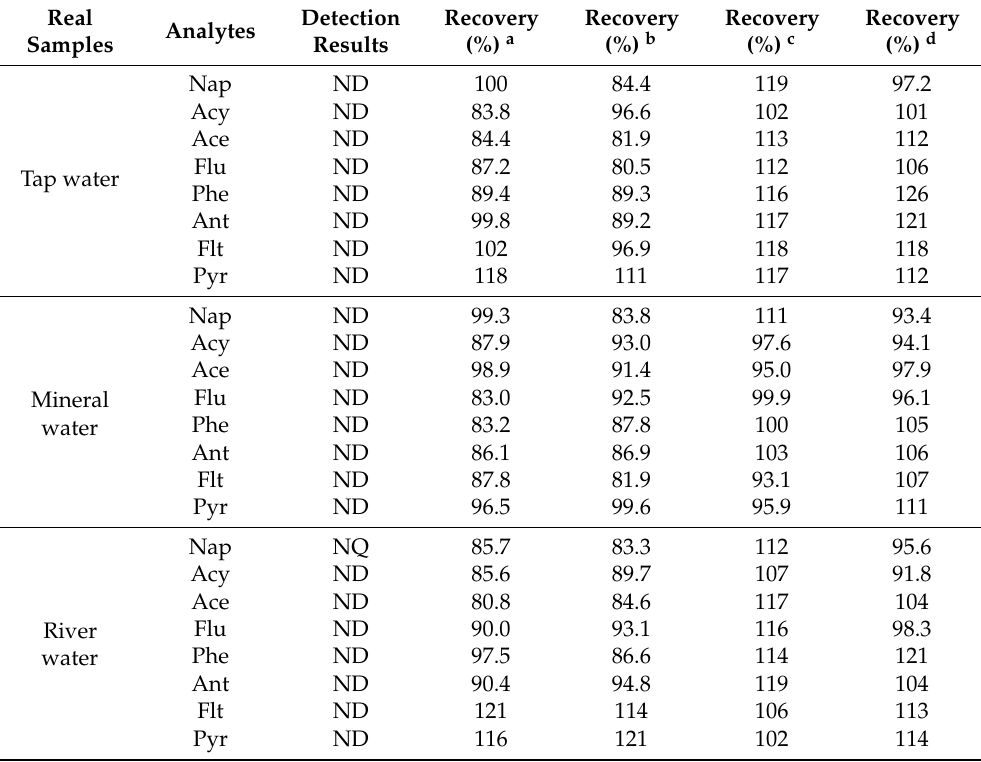
Table 2. Analytical results and relative recoveries of several PAHs in real water samples.